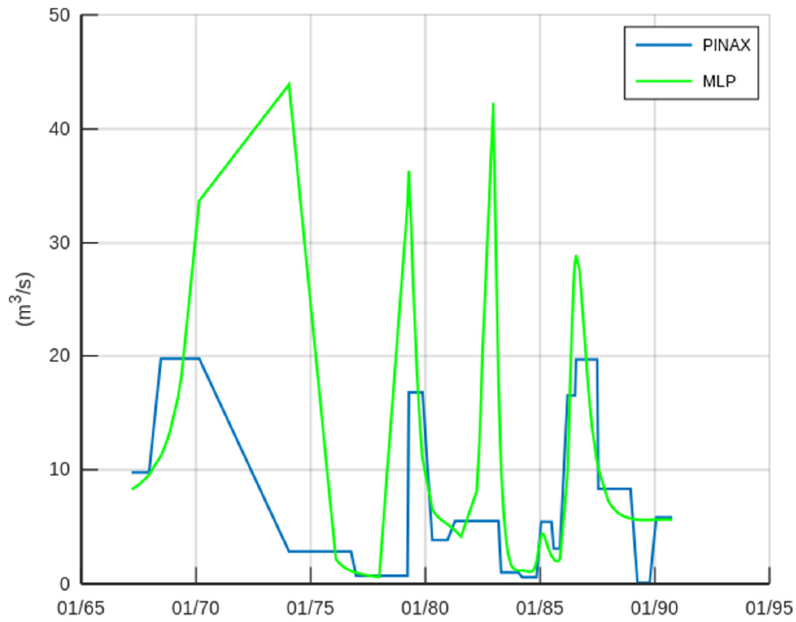
Figure 12. Agrafiotis case study—discharge over time corresponding to a constant stage (equal to mean observed stage) as it is calculated by the 16 PINAX ‐ obtained regressions and the MLP.